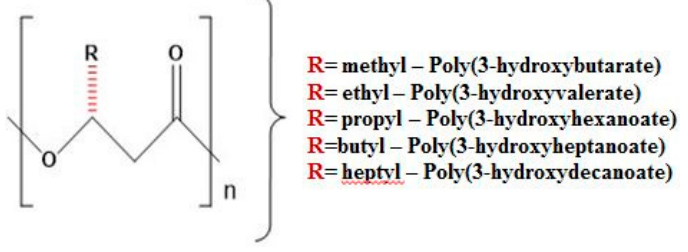
Figure 1. General Structure of Polyhydroxyalkanoate.